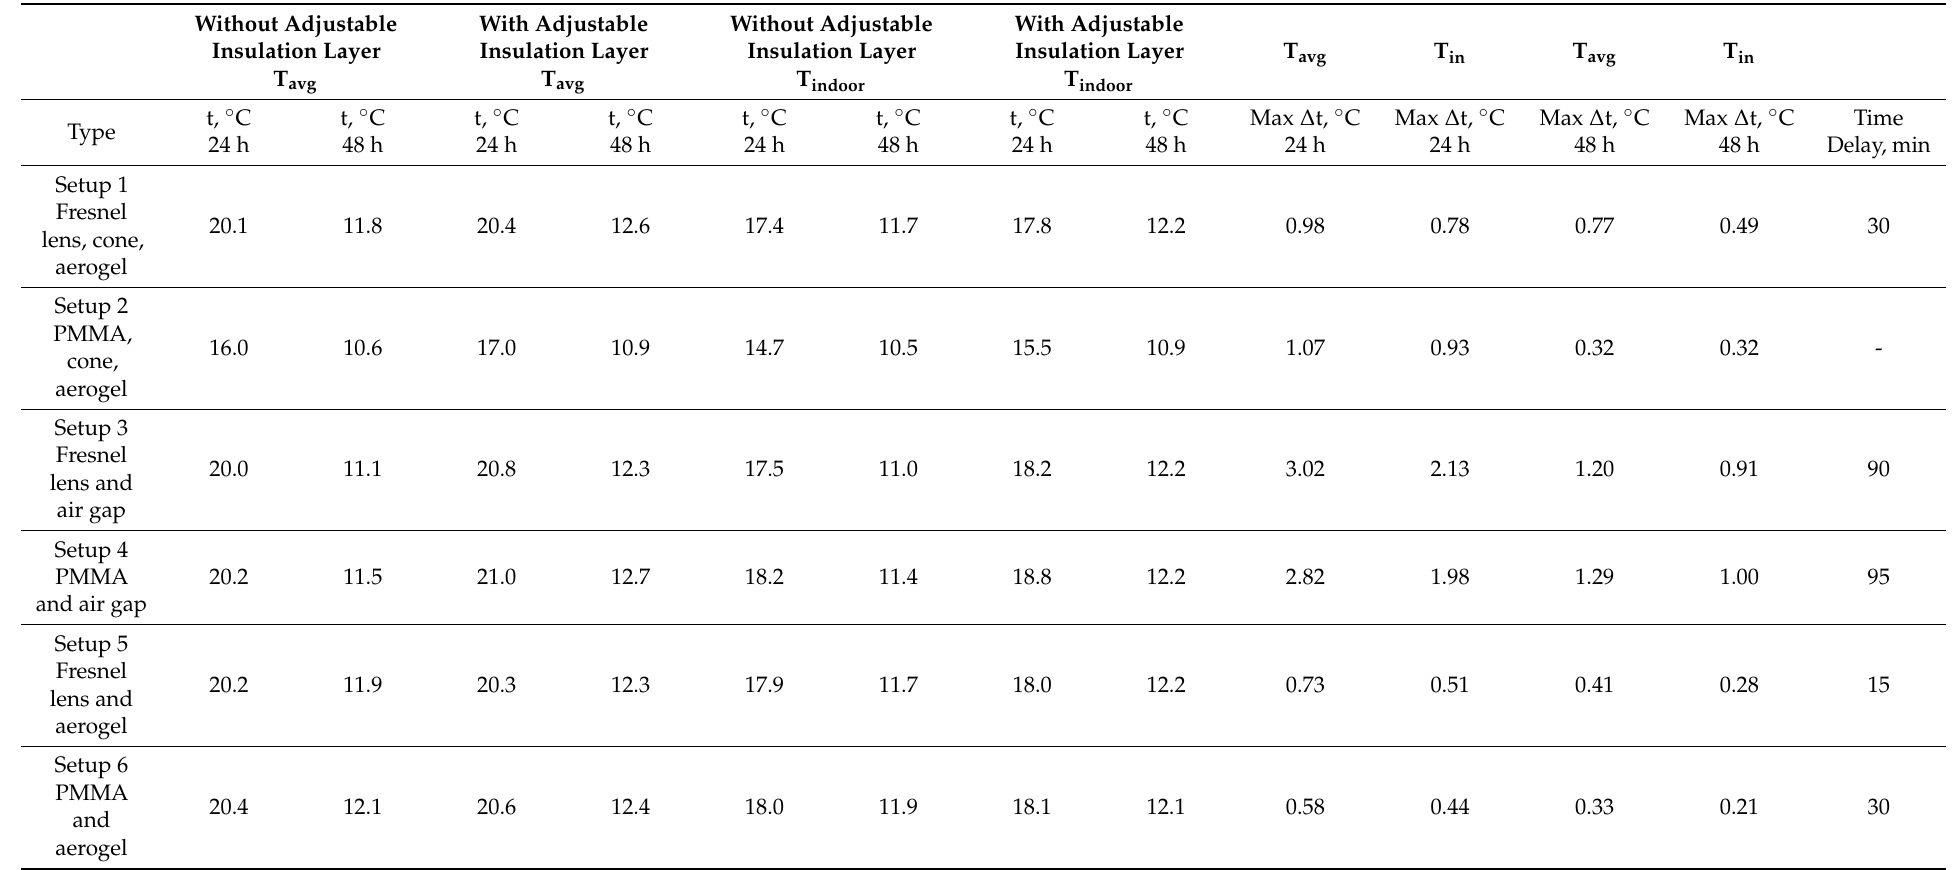
Table 6. Highest and lowest average phase-change material temperature in solar facade